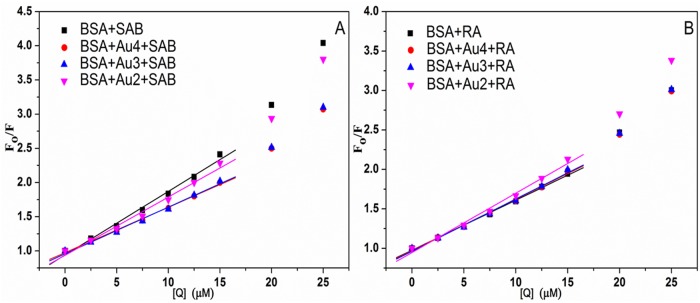
The Stern-Volmer plots of BSA–drug systems without and with Au NPs at 298 K.The Stern-Volmer plots for BSA fluorescence quenching by SAB (A) and RA (B) in the absence of Au NPs (square) and in the presence of Au4 (circle), Au3 (up triangle) and Au2 (down triangle). CBSA = 5.0 × 10-6 mol L-1, the concentration of Au NPs was 10.0 × 10-11 mol L-1, λ
ex = 280 nm, pH = 7.40.